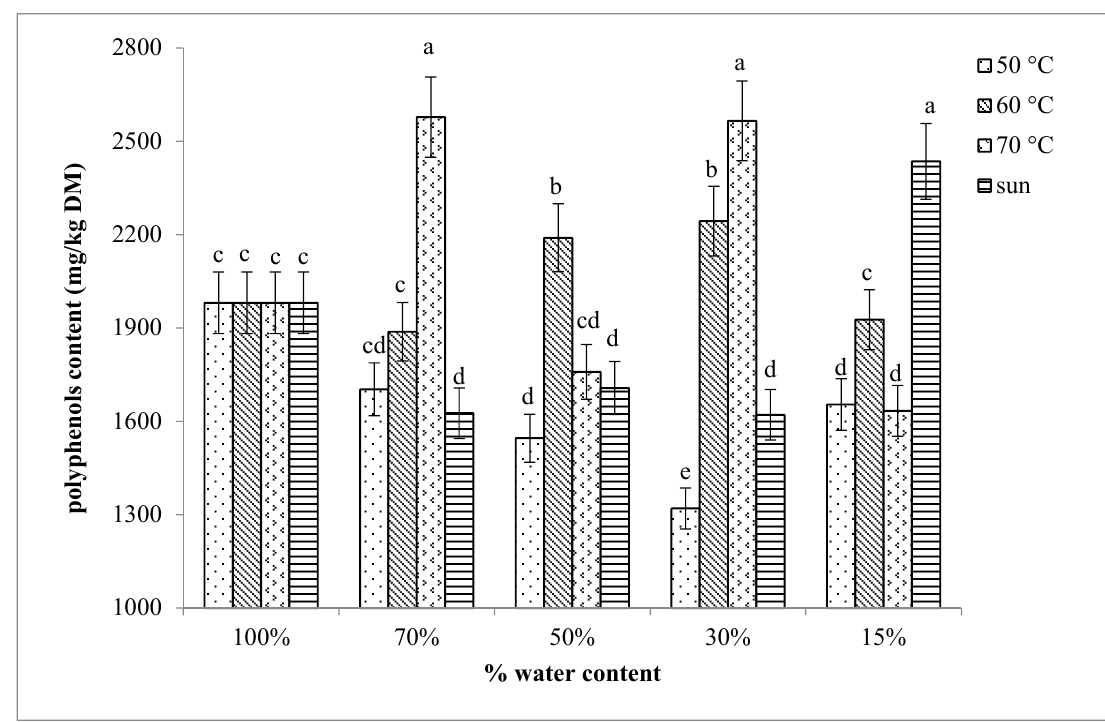
Figure 4. Polyphenol content at drying conditions. Bars are means with standard errors, and those with different letters are statistically different by Tukey’s test at α = 0.05.